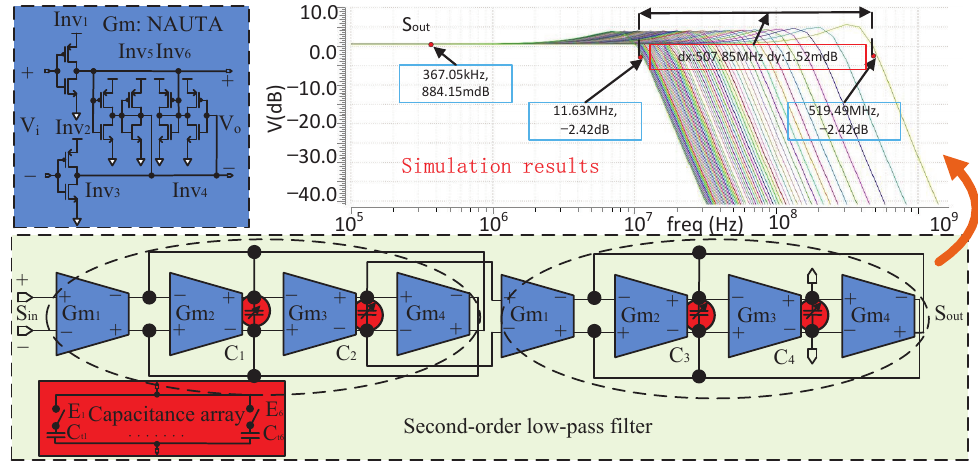
Figure 7. Circuit structure and simulation results of the fourth-order programmable